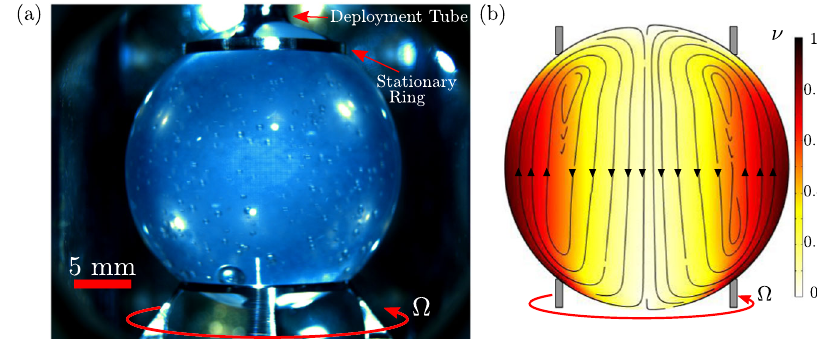
Fig. 1 The ring-sheared drop (RSD) with the bottom ring rotating. a Image of the ring-sheared drop aboard the ISS showing a pre-sheared 8 mg/mL human insulin solution spinning at 30 rpm. b Axisymmetric computation of primary (color map of normalized azimuthal velocity, ν ) and secondary (black arrowed streamlines in the azimuthal plane) fl ow of a Newtonian fl uid in the RSD sheared at 30 rpm.